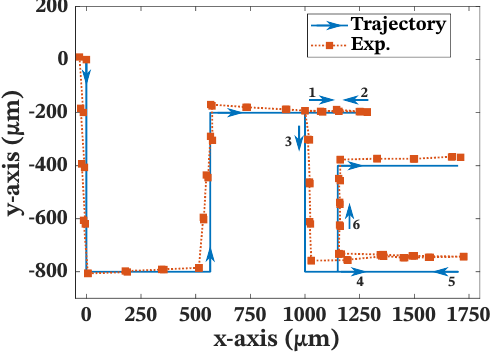
Figure 15. Bi-dimensional trajectory forming the Universite de Technologie de Compiegne acronym on a 2 × 2